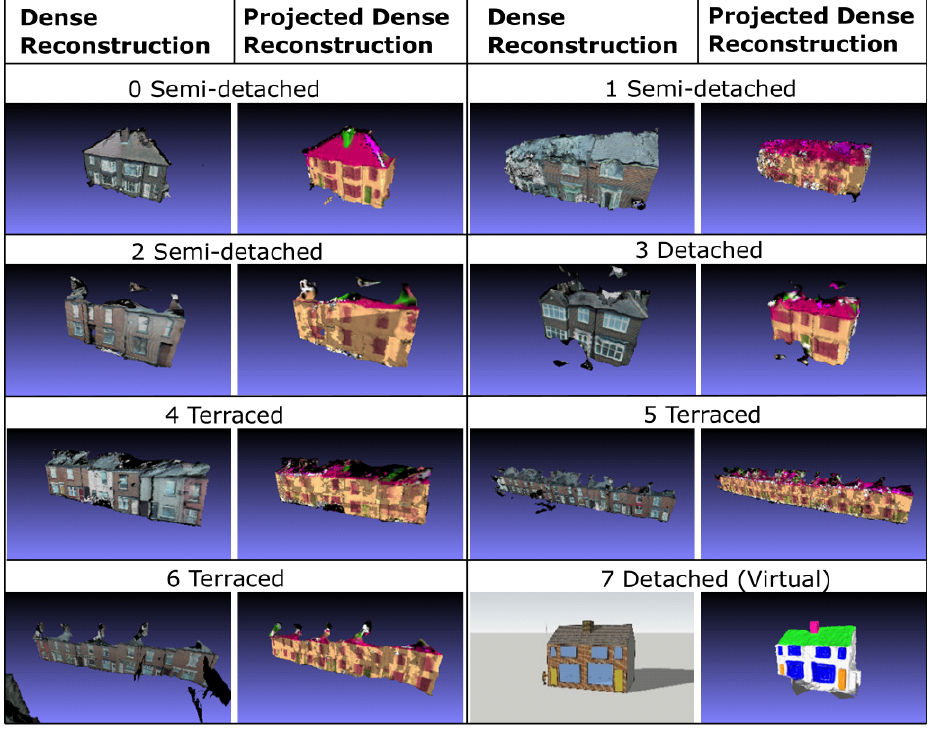
Figure 7. The numbered building samples used in this study; the dense reconstruction is built by the multi-view stereo (MVS) algorithm as aforementioned; the projected dense reconstruction is the dense reconstruction model with semantic segmentation mask projected; all samples are numbered and marked with their building types.